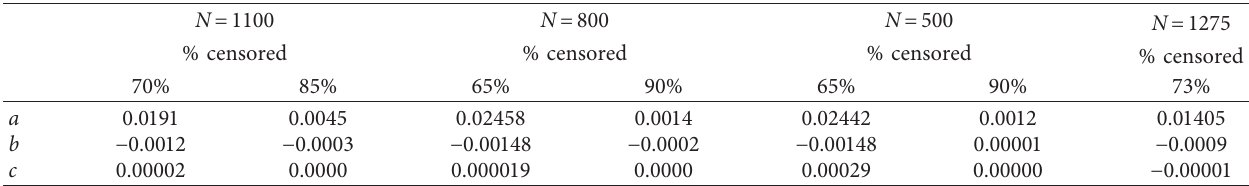
Table 2: Fitted coefficients for baseline hazard functions ∗ .